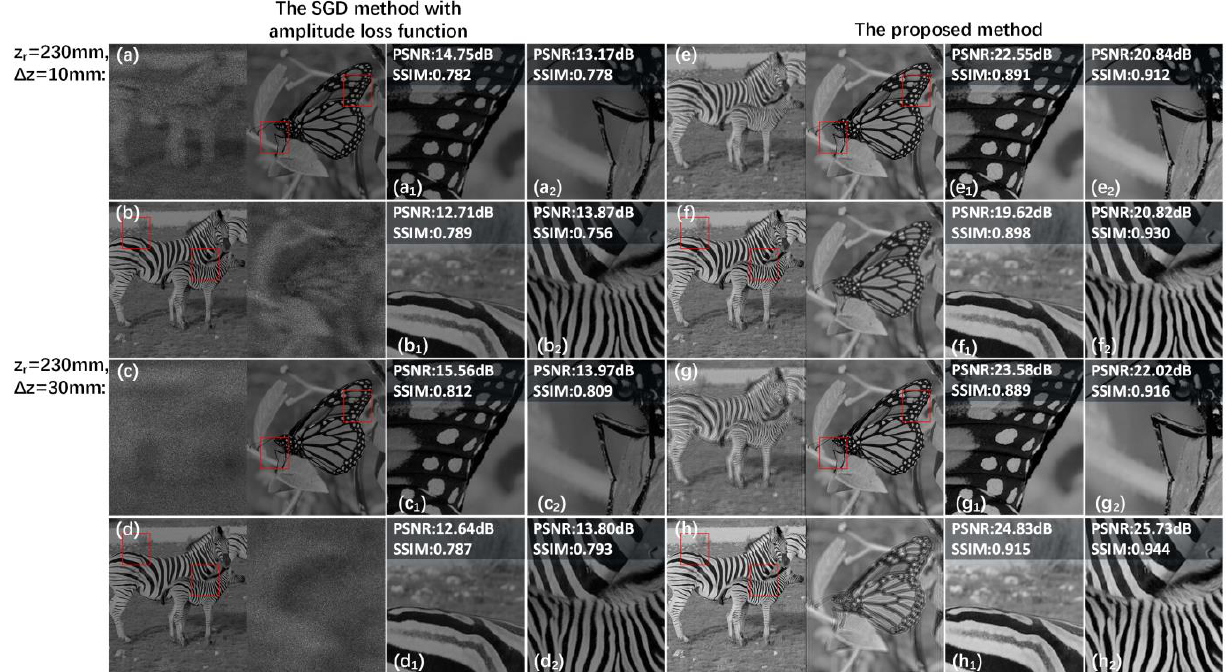
Table 1. Comparison of the optimization time for 100